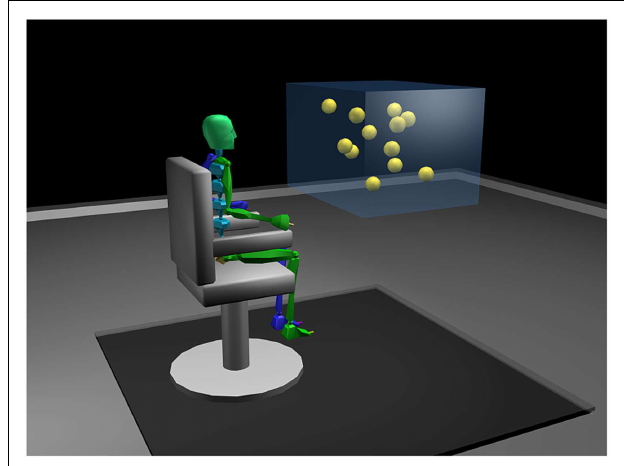
FIGURE 1 | Illustration of the experimental 3D-MOT set-up in the CAVE environment .The walls of the virtual cube are shown here for illustration purposes.They were not visible in the actual set-up.